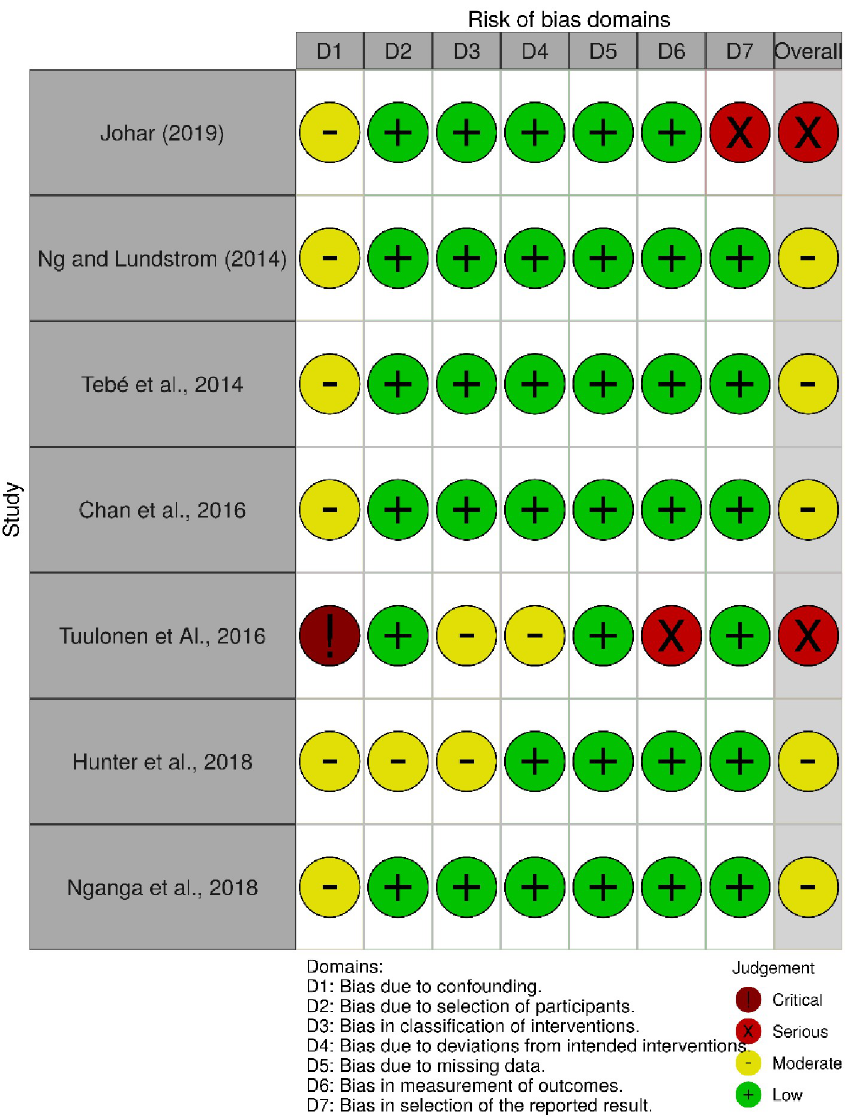
Fig 2. Traffic-light plot for the risk of bias domains in ROBINS-I for the selected studies.